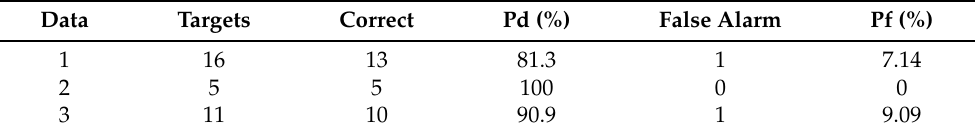
Table 2. Detection performance of the proposed method under different sites, where Num denotes the number of targets, Pd denotes the detection rate, and Pf denotes the false alarm